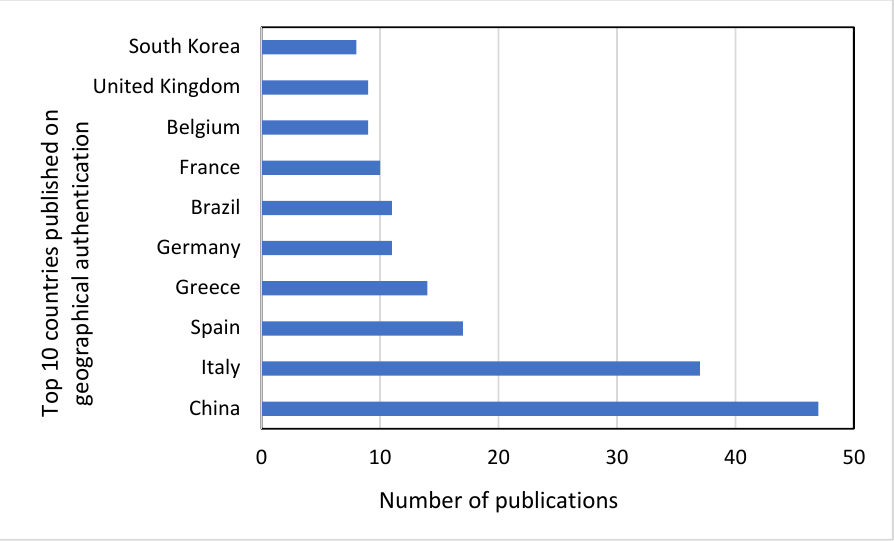
Figure 2. Origin countries of publications on geographical origin authentication.